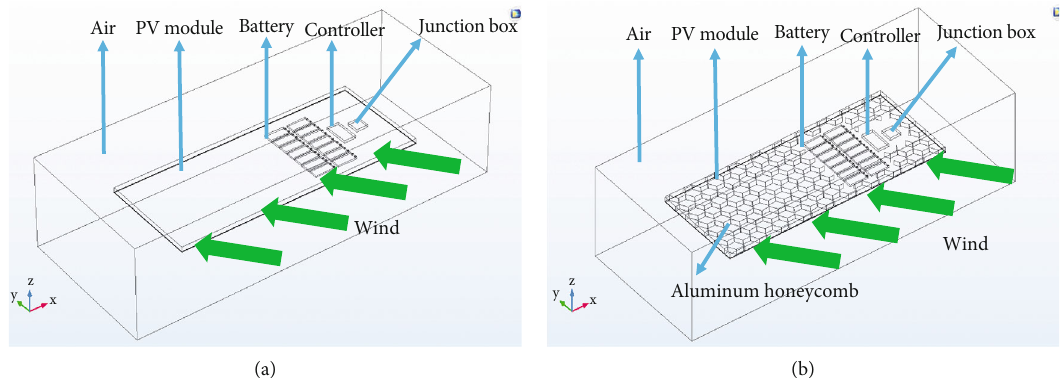
Figure 2: The schematic of the PV – battery integrated systems: (a) G – PBIS, and (b) H – PBIS.